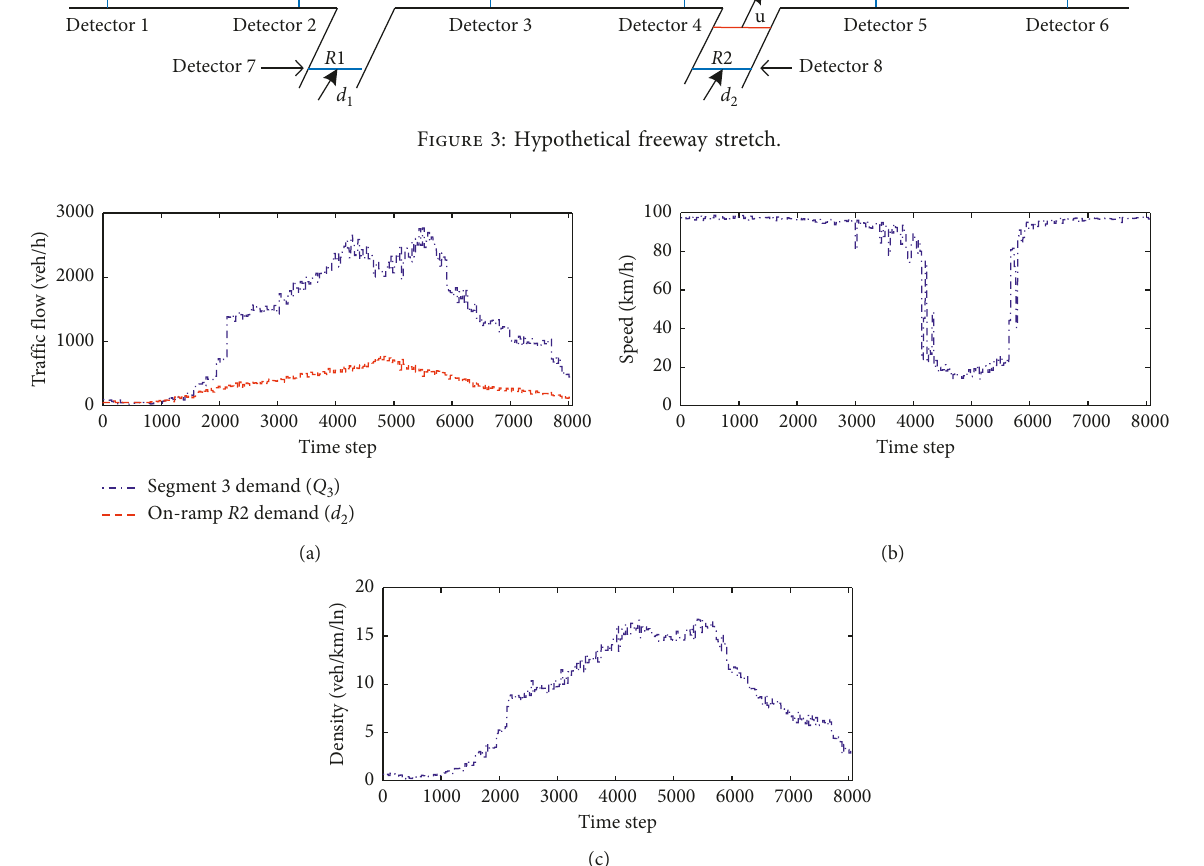
Figure 4: (a) Demands of segment 3 and on-ramp R 2, (b) average speed of segment 3, and (c) average density of segment 5.